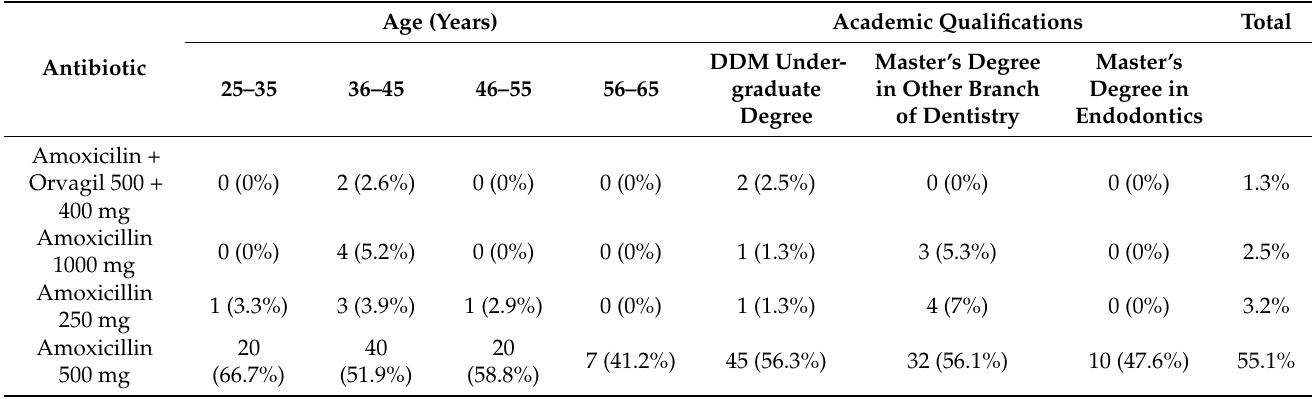
Table 2. First-choice antibiotics according to the participants’ age and academic qualifications (statistically significant differences are highlighted in